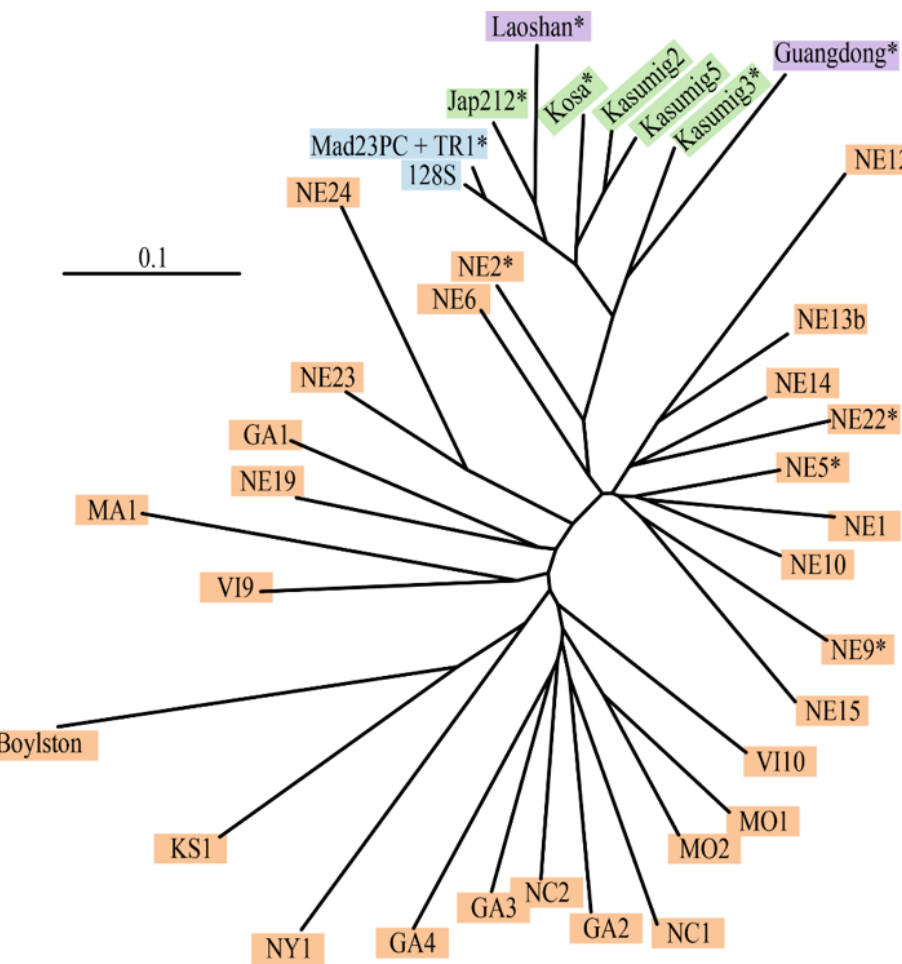
Figure 1: Neighbor-Joining tree built with all the pinewood nematode samples used in this study. Tree based on Cavalli-Sforza and Edwards distances (Cavalli-Sforza and Edwards 1967), corrected for null alleles (Chapuis and Estoup, 2007). The American (native) samples were highlighted in orange, the Japanese samples in green, the Chinese samples in purple and the Portuguese samples in blue. “*” indicates that the corresponding site sample was used in the ABC